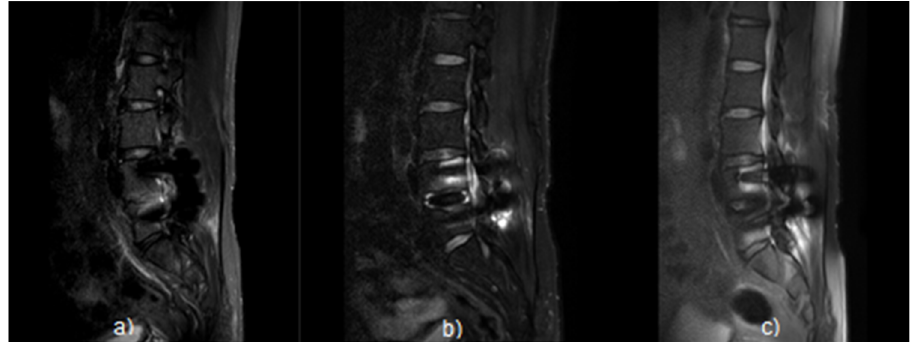
Figure 7. L4, L5 L-Spine Sagittal image of patientswho had transplant surgery. In the T2 Sagittal Images, the T2 CS-SEMAC (SPIR) Fat Suppression image has an excellently less signal loss compared to T2 STIR Fat Suppression. T2 STIR ( a ); T2 mDixon (O-MAR) ( b ); and T2 CS-SEMAC (SPIR) ( c ).